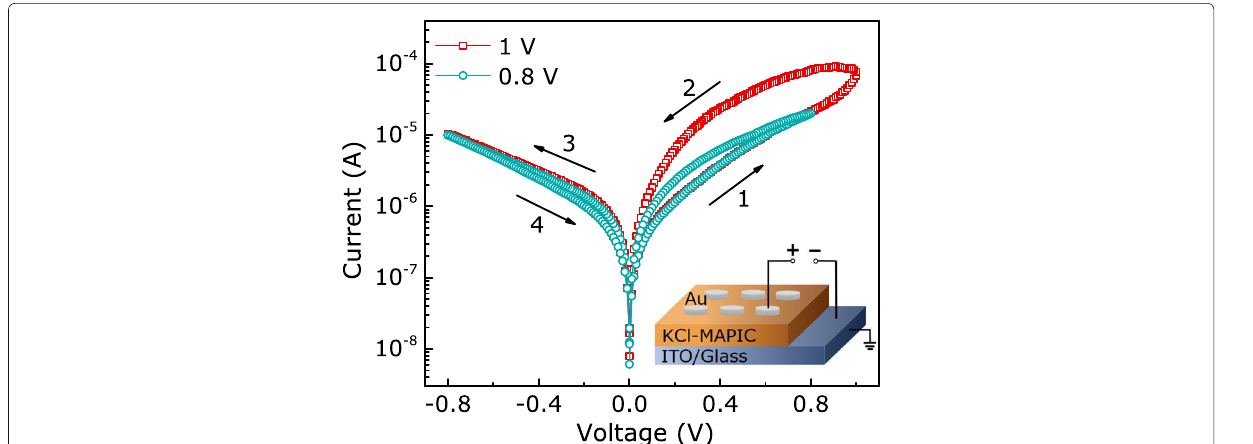
Fig. 3 The semi-logarithmic plots of the I − V curves of Au/KCl-MAPIC/ITO/glass devices in voltage sweeping mode. The inset displays the schematic measurement. Au electrodes with diameters of 300 μ m were deposited on the surface of KCl-MAPIC films by magnetron